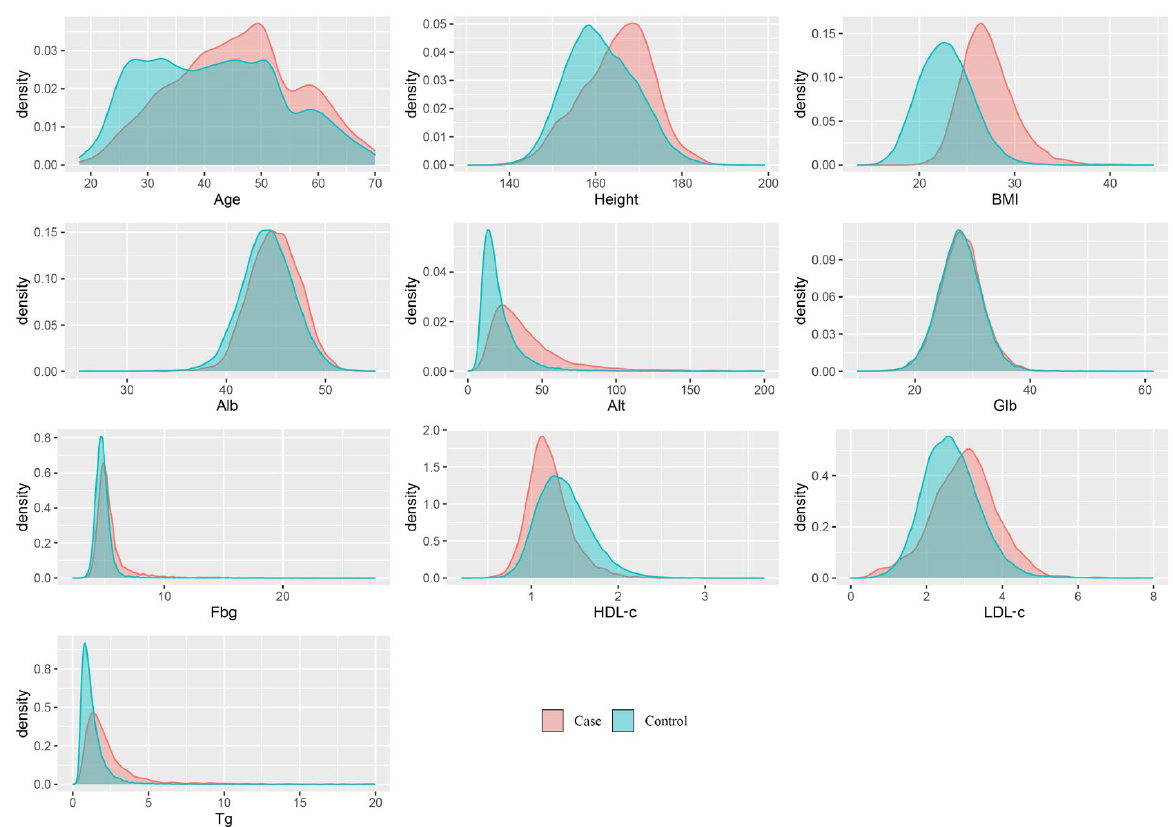
Figure 3. The density distribution of all predictive variables. BMI: body mass index; Alb: albumin; Alt: glutamic-pyruvic transaminase; Glb: globulin; Fbg: fasting blood-glucose; HDL-c: high-density lipoprotein cholesterol; LDL - c: low - density lipoprotein cholesterol; Tg: triglyceride Table 4. Assessment of eight machine learning